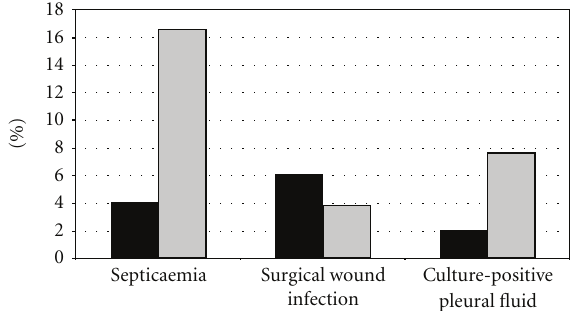
Figure 1: Proportion (%) of patients with infectious complications (at 30 days) after lung transplantation. Black bars: MCBT group. Grey bars: conventional therapy group.